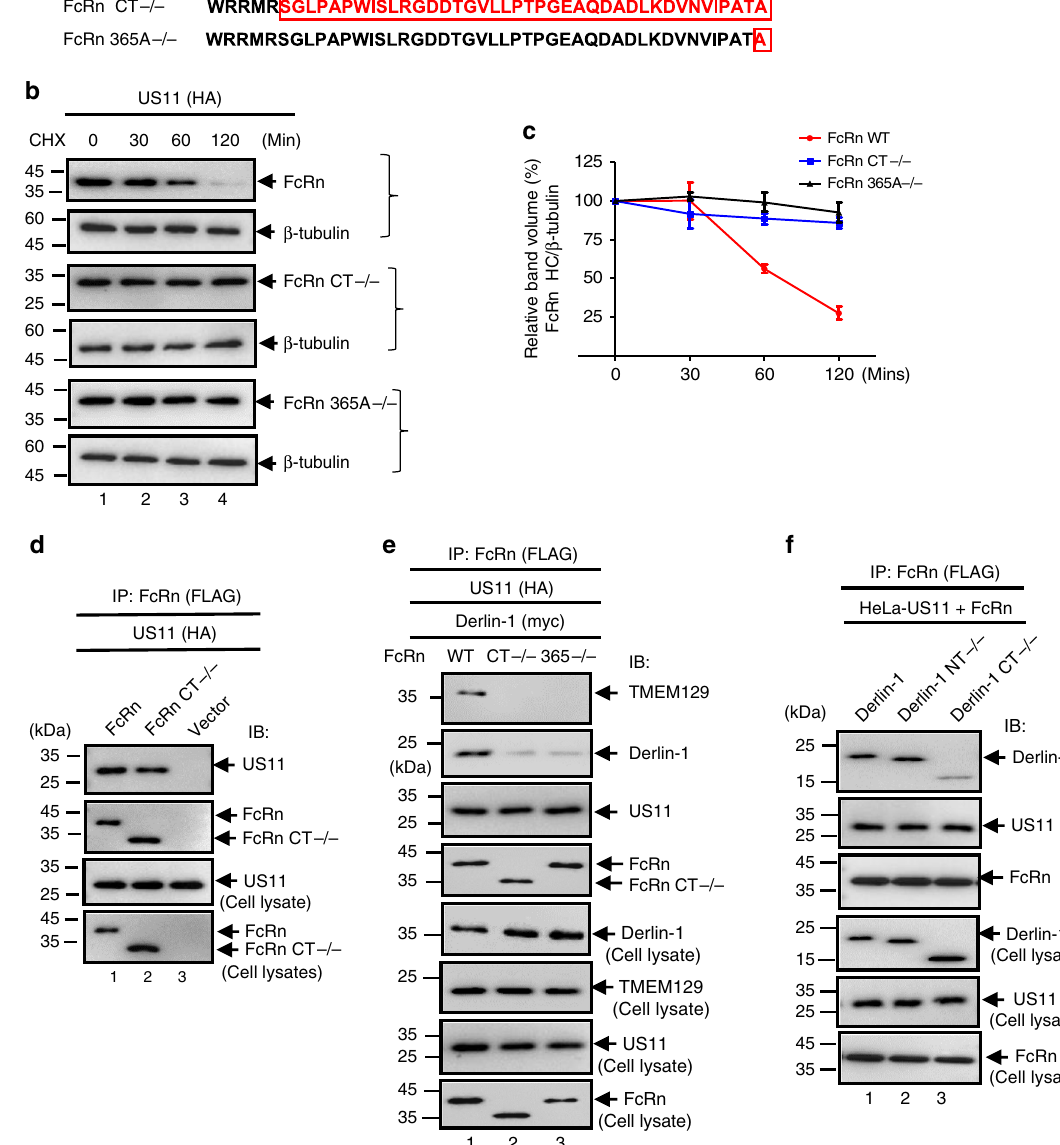
Fig. 5 The cytoplasmic tail of FcRn contributes to US11-mediated degradation. a Depiction of tailless FcRn (CT − / − ) and FcRn HC deleting alanine residue 365 (365A − / − ) in the cytoplasmic tail. Letter(s) in red represent(s) the deleted amino acid(s). b , c Tailless FcRn or FcRn 365A − / − resists degradation in the presence of US11. HeLa US11 ( b , top), HeLa US11 + FcRn CT − / − ( b , middle), or HeLa US11 + FcRn365 − / − cells ( b , bottom) were treated with CHX (100 μ g/ml) and chased for the indicated time in the absence of proteasome inhibitors. The cells were lysed after CHX treatment and cell lysates (20 μ g) were subject to western blotting with Abs as indicated. The level of wild-type FcRn ( c , red), tailless FcRn ( c , blue), and mutant FcRn 365A − / − ( c , black) in HeLa US11 cells at different time points was quanti fi ed as the percentage of the β -tubulin level. The percentage of time point 0 (min) is assigned a value of 100% and the values from other time points are normalized to this value ( c ). Error bars represented mean ± SEM of three independent repeats. d The US11 interacts with tailless FcRn protein. The cell lysates from HeLa FcRn + US11 (lane 1), HeLa US11 + FcRnCT − / − (lane 2), and HeLa control (lane 3) were immunoprecipitated by anti-FLAG Ab for FcRn. The US11 molecules that coprecipitate in the complex are indicated. e The cytoplasmic tail of FcRn is required for tightly binding to Derlin-1 in the presence of US11. HeLa FcRn + US11 (lane 1), HeLa US11 + FcRn CT − / − (lane 2), and HeLa US11 + FcRn 365A − / − (lane 3) cells were transfected with Derlin-1 plasmid. Forty-eight hours later, cell lysates were immunoprecipitated with anti-FLAG Ab to detect FcRn. f The C-terminus of Derlin-1 is required for tightly binding to FcRn in the presence of US11. The HeLa US11 + FcRn stable cells were transfected with a plasmid encoding Myc-tagged Derlin-1 (WT), Derlin-1 lacking its N-terminus (NT − / − ) or C-terminus (CT − / − ), respectively. Forty-eight hours after transfection, the cell lysates (0.5 mg) were immunoprecipitated with rabbit anti-FLAG Ab. All immunoprecipitates or cell lysates (20 μ g) as internal controls were subject to western blotting with corresponding Abs as indicated ( d – f